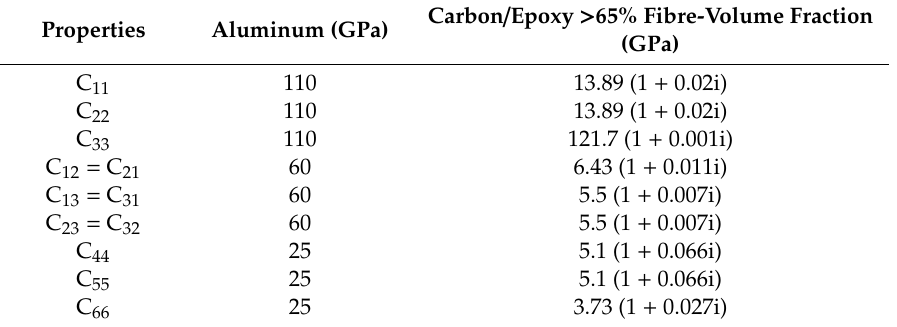
Table 2. Material properties [23].